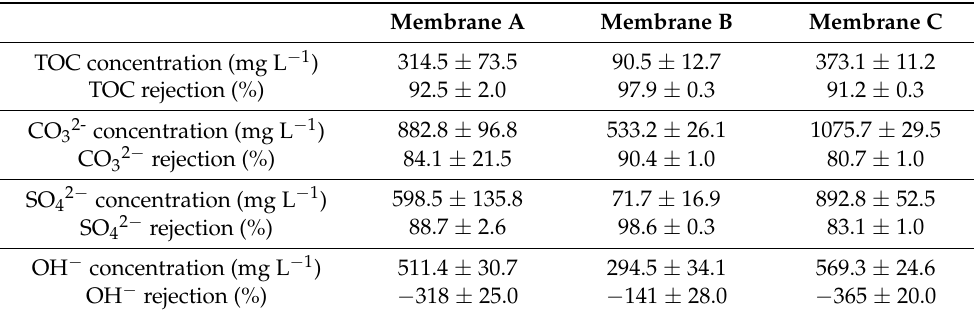
Table 6. Average permeate concentration and rejection of TOC, CO 32 − , SO 42 − , and OH − for Membranes A, B, and